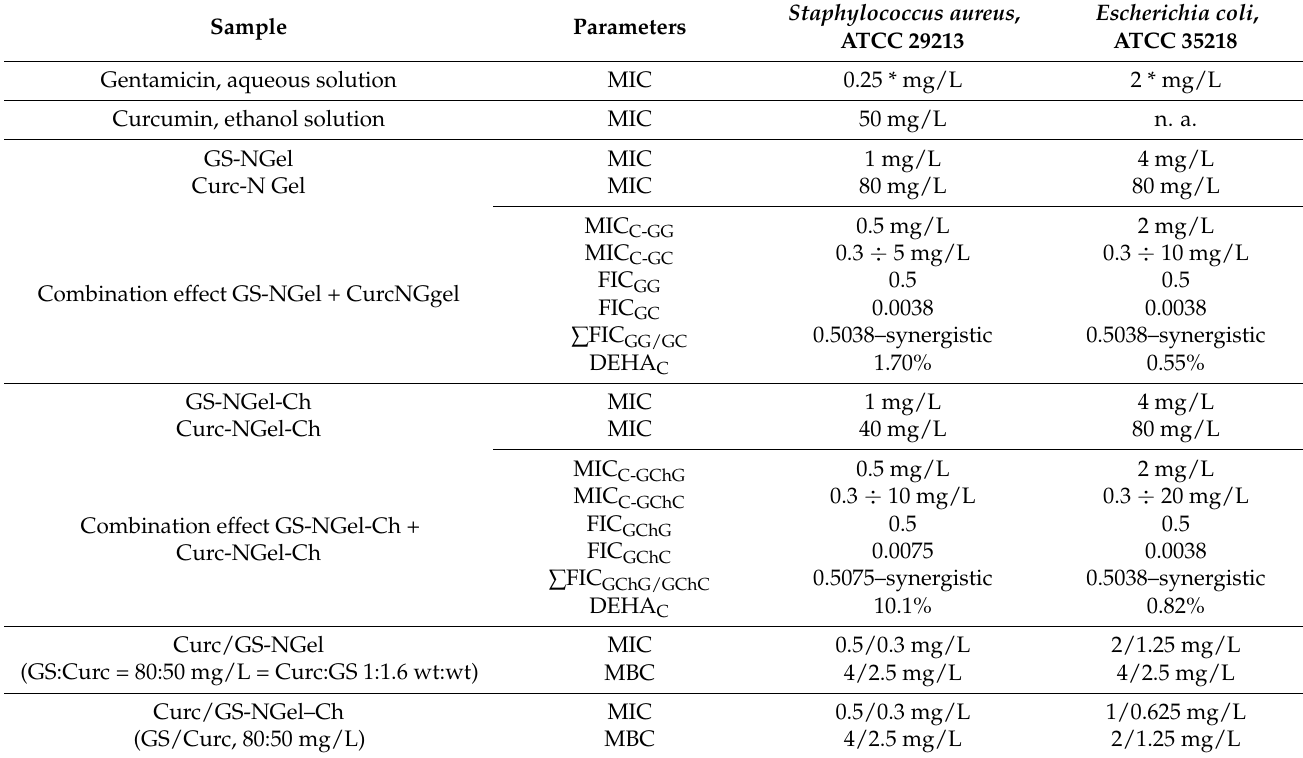
Table 4. Antibacterial activity of free and formulated into hybrid niosomal in situ gels curcumin and gentamicin